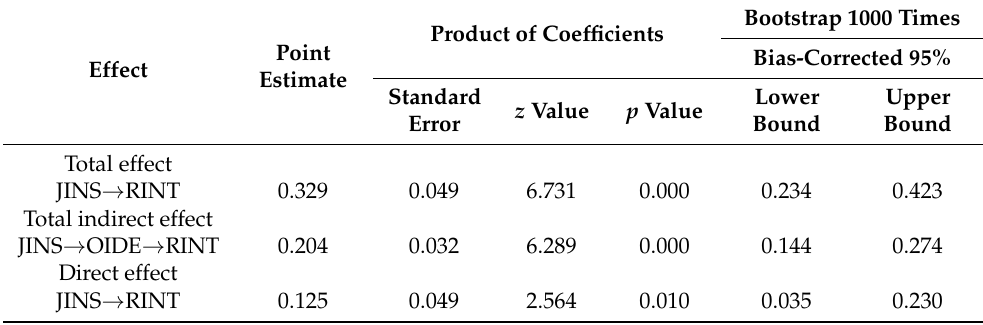
Table 3. Analyses of the indirect effect of the mediating